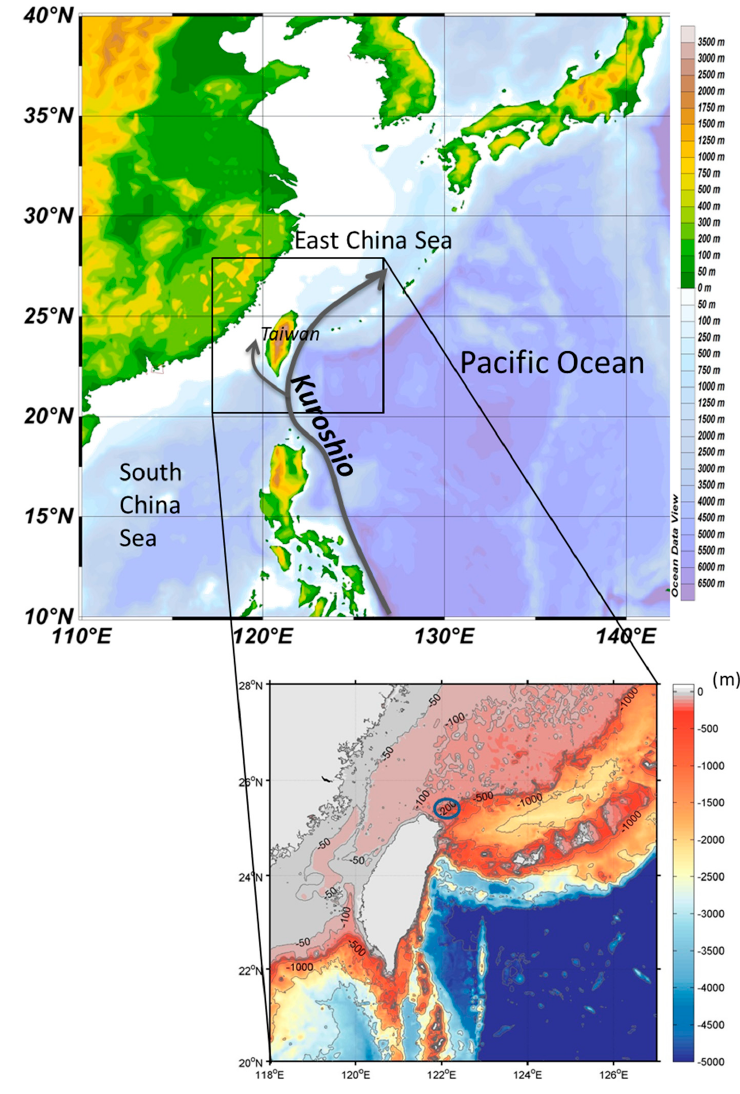
Figure 1. Bathymetry around Taiwan. The blue circle in the zoom-in plot denotes the cold dome